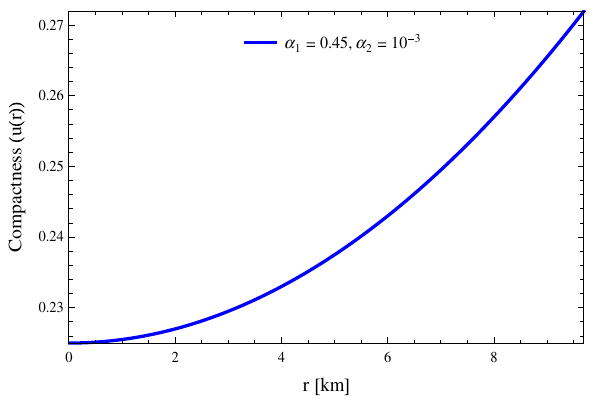
Fig. 5 Behaviour of the energy condition when α 1 = 0 . 45, α 2 = 10 − 3 asfunctionsof r forfixedvalueofDEparameter γ = + 0 . 9forspherical object PSR J1614-2230